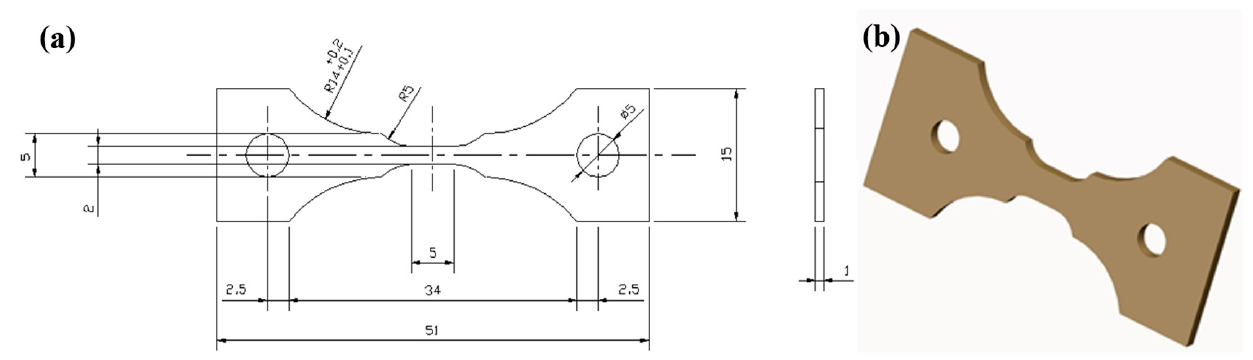
Figure 2. In situ SEM tensile tests specimens: ( a ) shape and dimensions (unit: mm); ( b ) sample diagram.